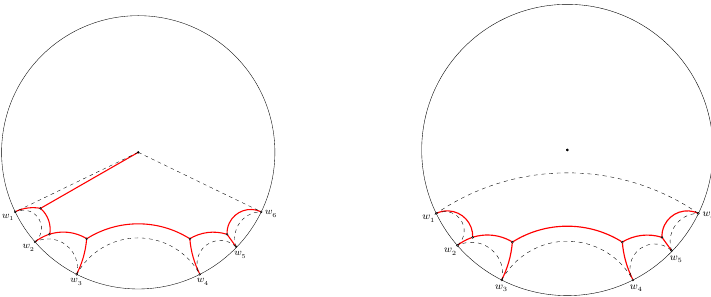
Figure 2 . Holographic Steiner trees: (a) non-ideal N = 7 graph, one edge ends in the center, (b) Figure 1 . General tree. ideal N = 6 graph, all edges end on the boundary circle. The associated hyperbolic polygons are shown in dashed